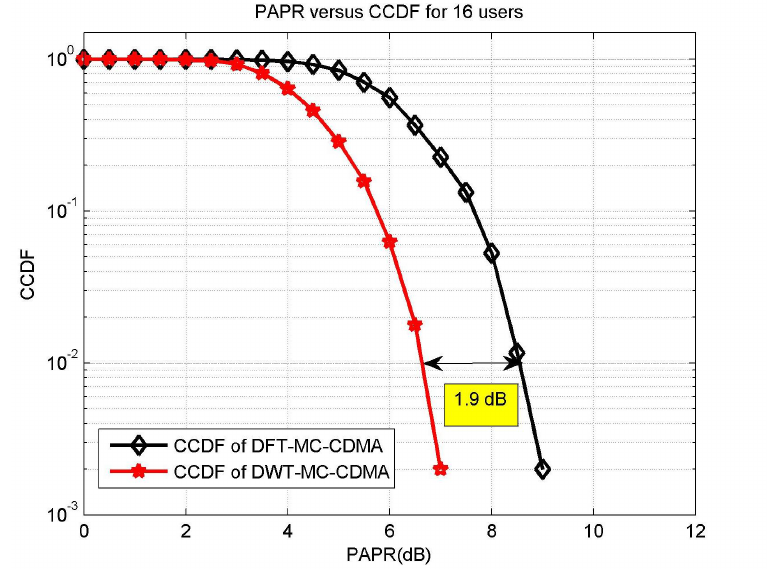
Figure 14. CCDF-based performance comparison of DFT-MC-CDMA and